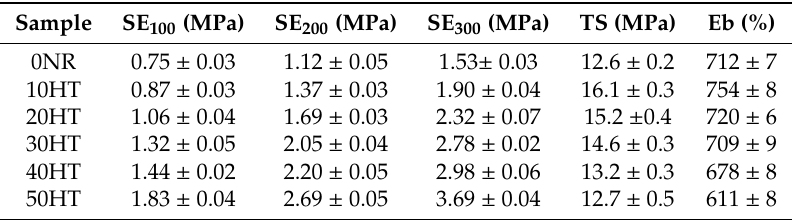
Table 4. Mechanical properties of biocomposites: the modules at 100%, 200%, and 300% of elongation (SE 100 , SE 200 , SE 300 ), tensile strength (TS) and elongation at break